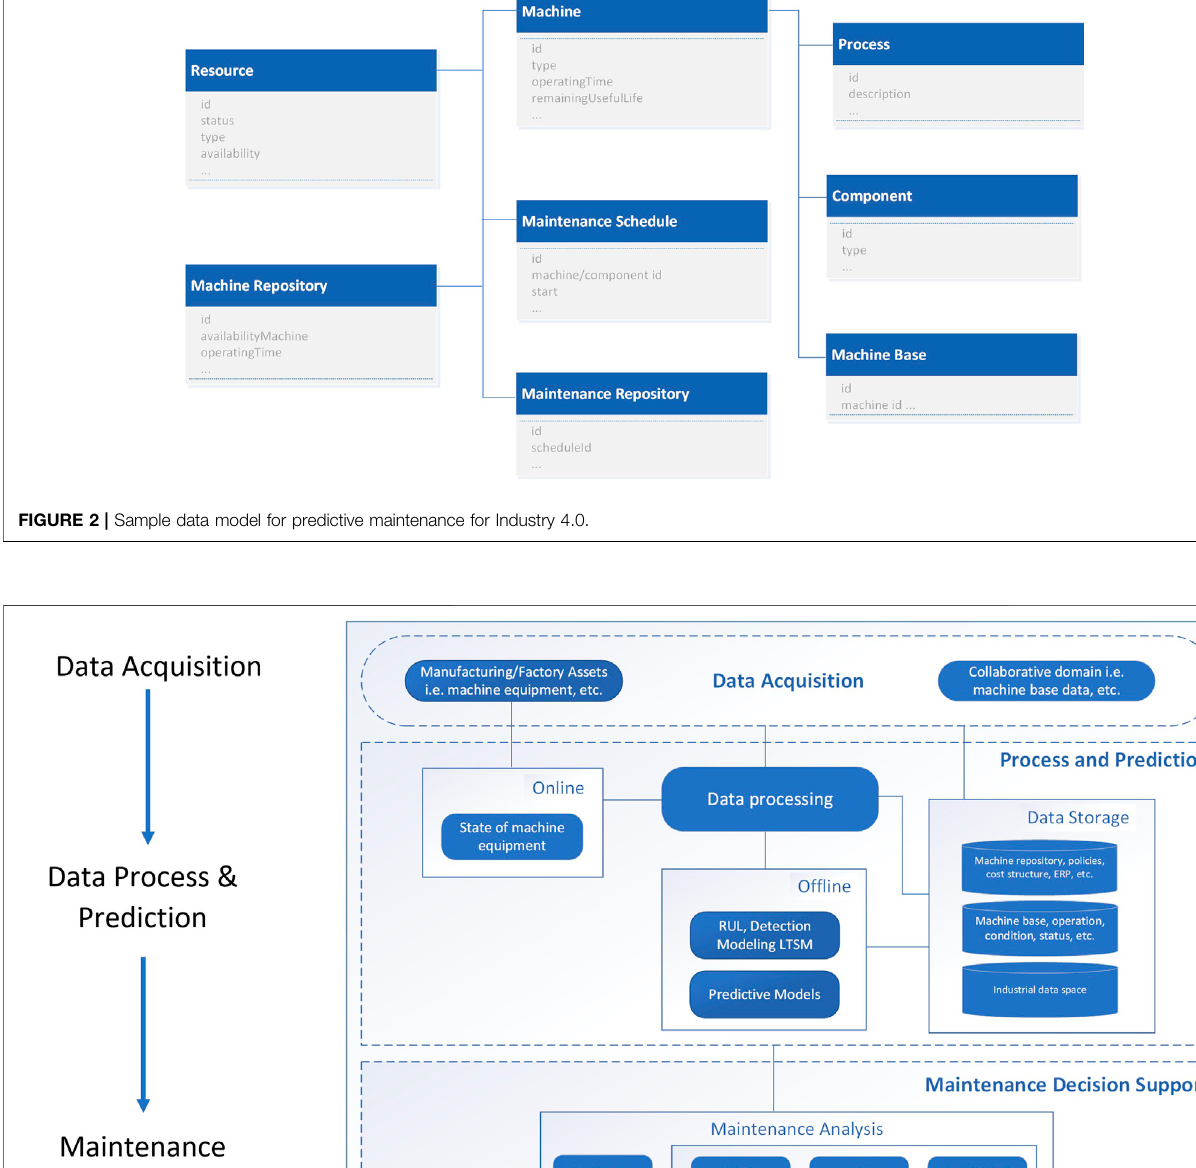
Frontiers in Big Data |